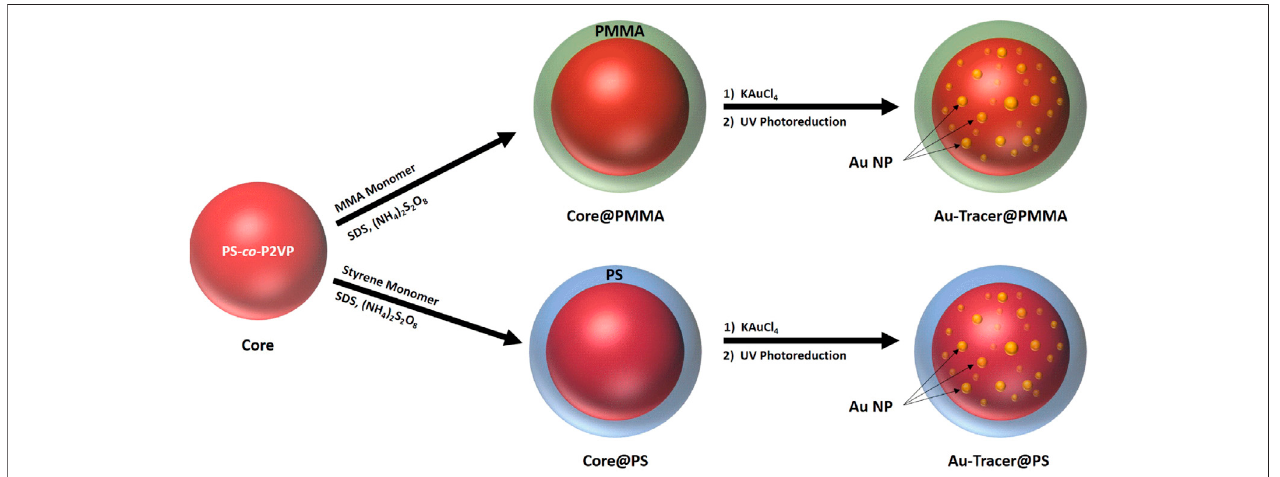
FIGURE 1 | Synthesis scheme for Au-Tracer@PMMA and Au-Tracer@PS particles.